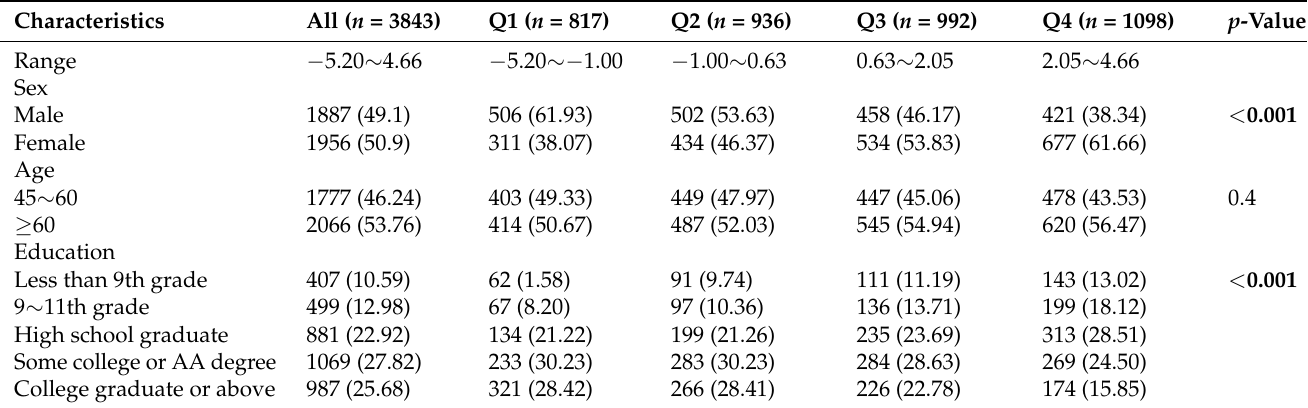
Table 1. DII quartile characteristic distribution of the basic situation of the research subjects [ n (%) or M(P25,